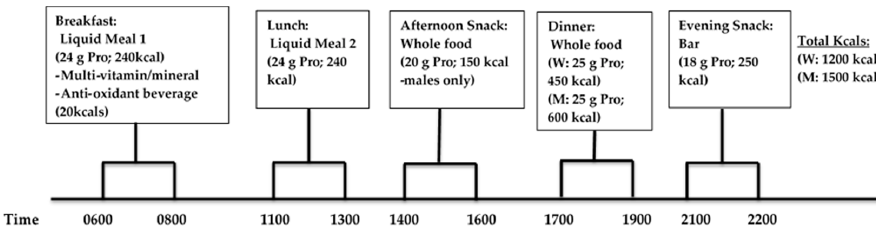
Figure 3. Daily timing and meal content during Phase 1 (Weight Loss, WL; P-CR).